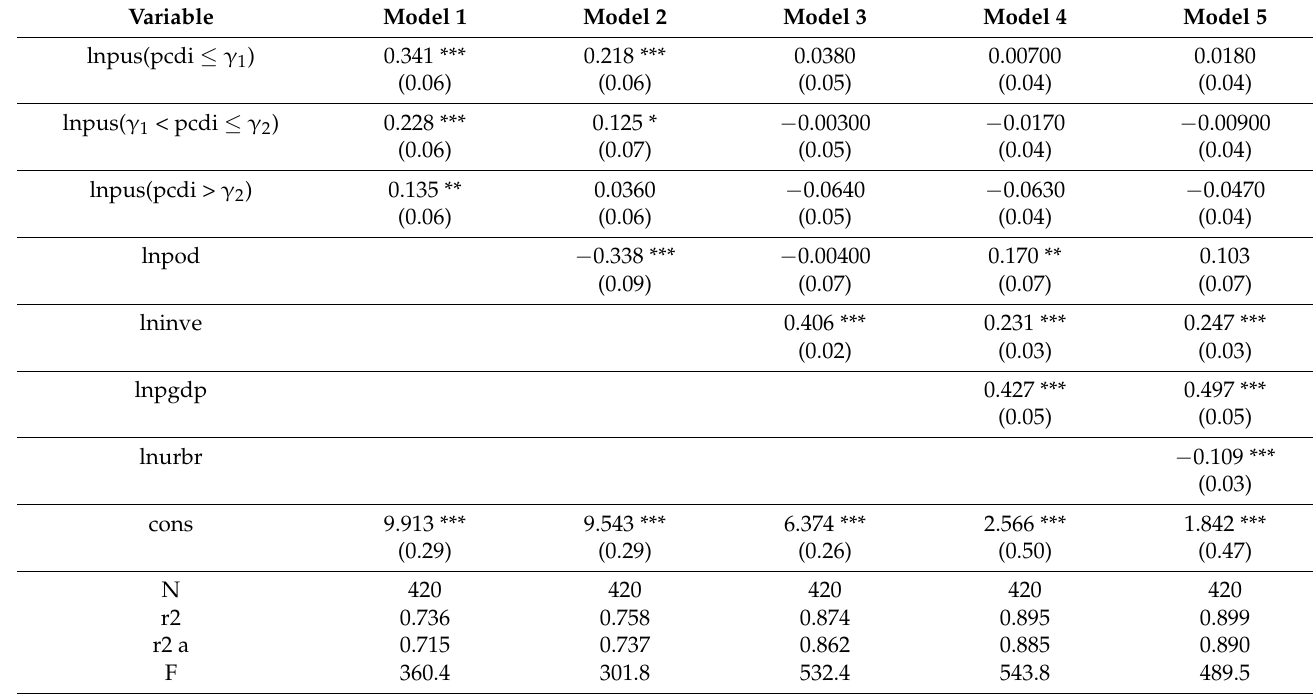
Table 5. Threshold regression results with PCDI level as the threshold variable.